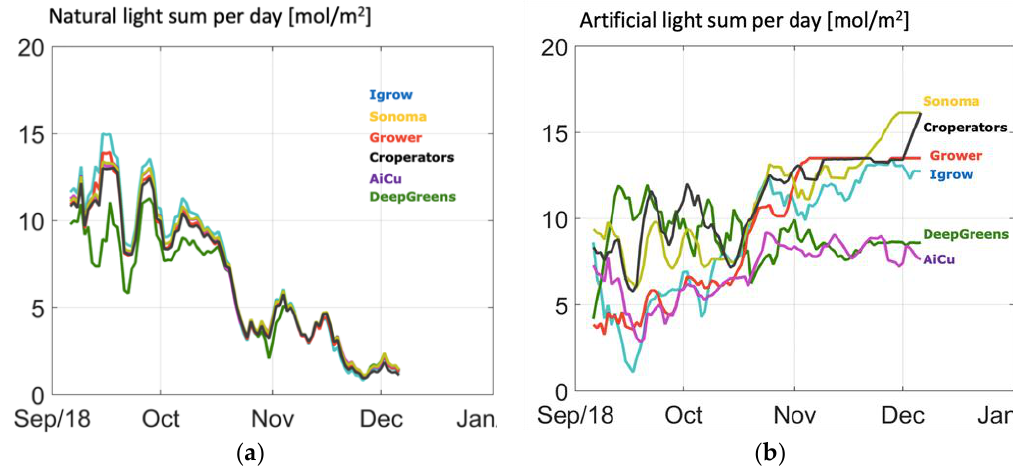
Figure 5. Course of daily light integral of ( a ) natural light and ( b ) artificial light only inside the greenhouse, just above the crop realized by di ff erent